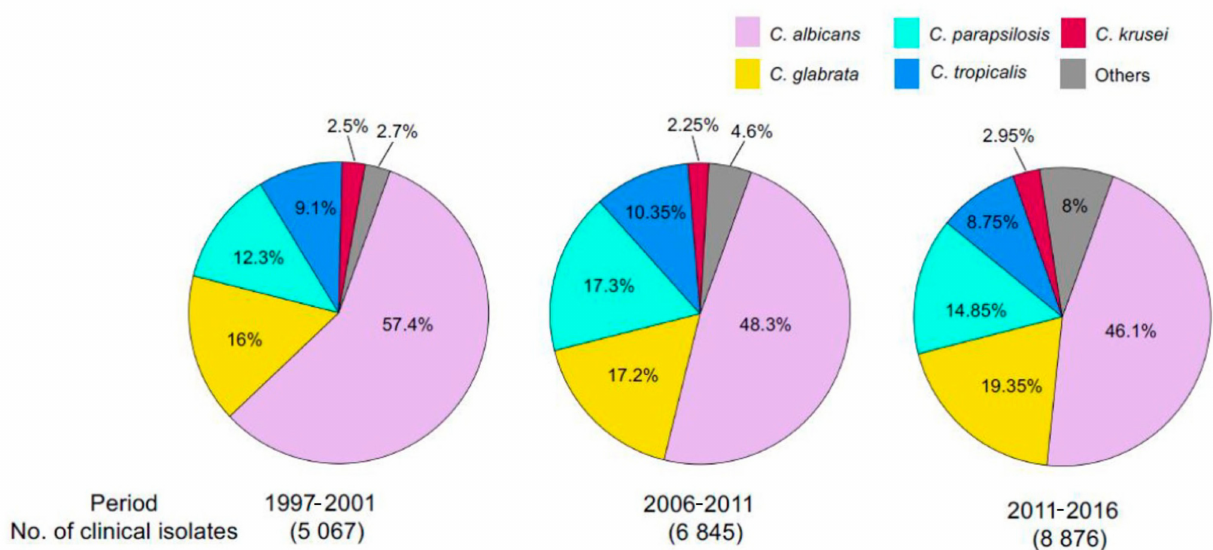
Figure 1. Distribution of Candida spp. in cases of invasive candidiasis. Species distribution in cases of invasive candidiasis over a period of 20 years is shown as percentage of total. Clinical isolates of candidemia were collected from hospitals in 41 countries as part of the global SENTRY Antifungal Surveillance Program and Candida spp. identified. Total number of clinical isolates for a given time period is given in parenthesis. Adapted from ref.